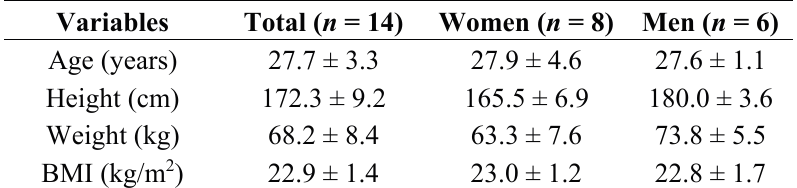
Table 2 . Characteristics of the participants.